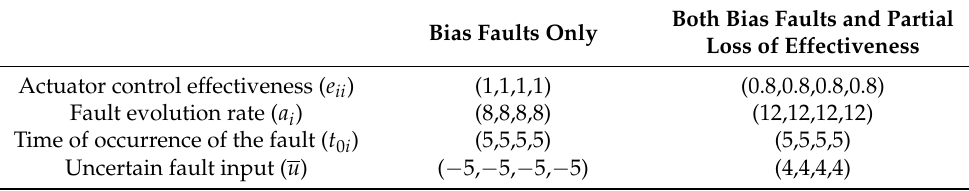
Table 1. Parameters of actuator faults.